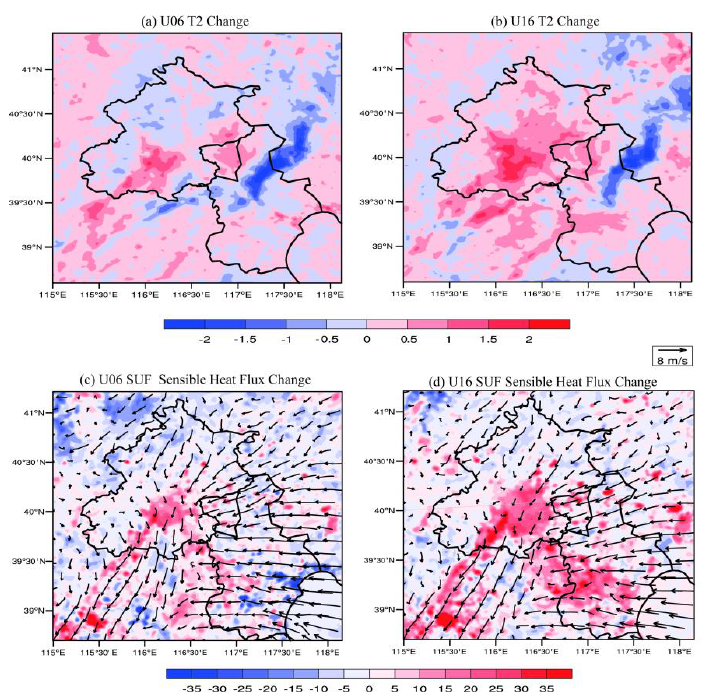
Figure 7. Changes in surface air temperature (°C) during the early period of precipitation (from 18:00 UTC on 19 July 2016 to 00:00 UTC on 20 July 2016). ( a ) Between the Urban06 test and No urban test; ( b ) between the Urban16 test and No urban test. ( c , d ) Same as ( a , b ) but for the mean surface sensible heat flux (shading; units: W m −2 ) and surface wind (vector; units: m s −1 ).